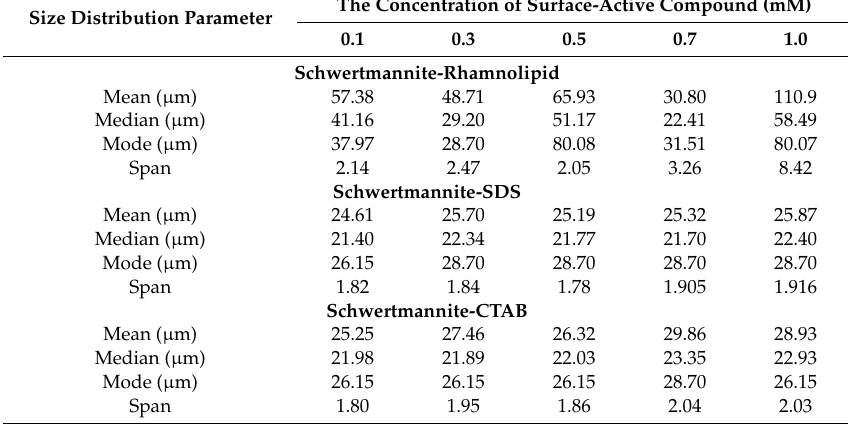
The size distribution of schwertmannite particles in the presence of surfactants and